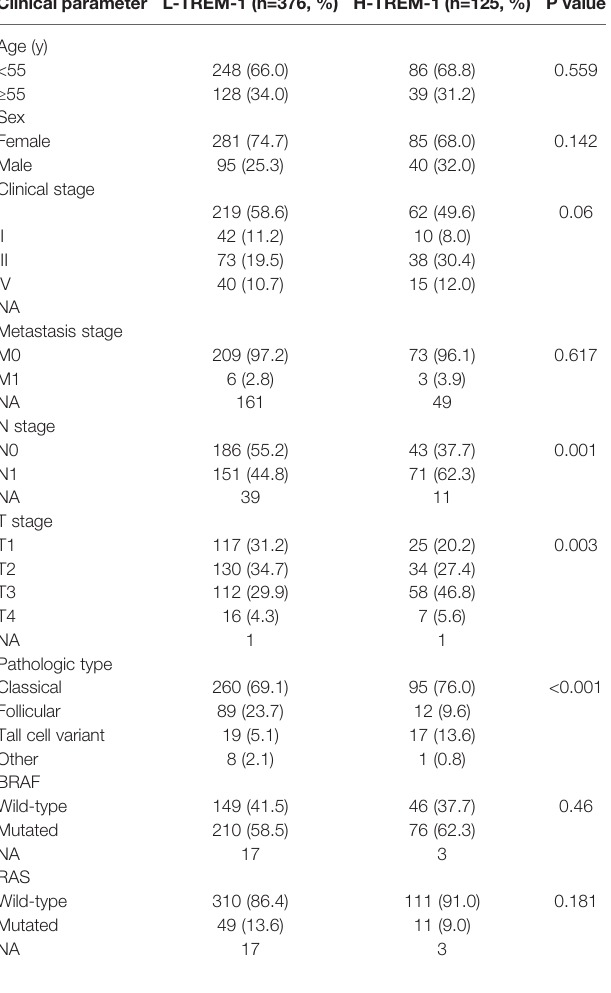
TABLE 2 | Association between TREM-1expression and clinical